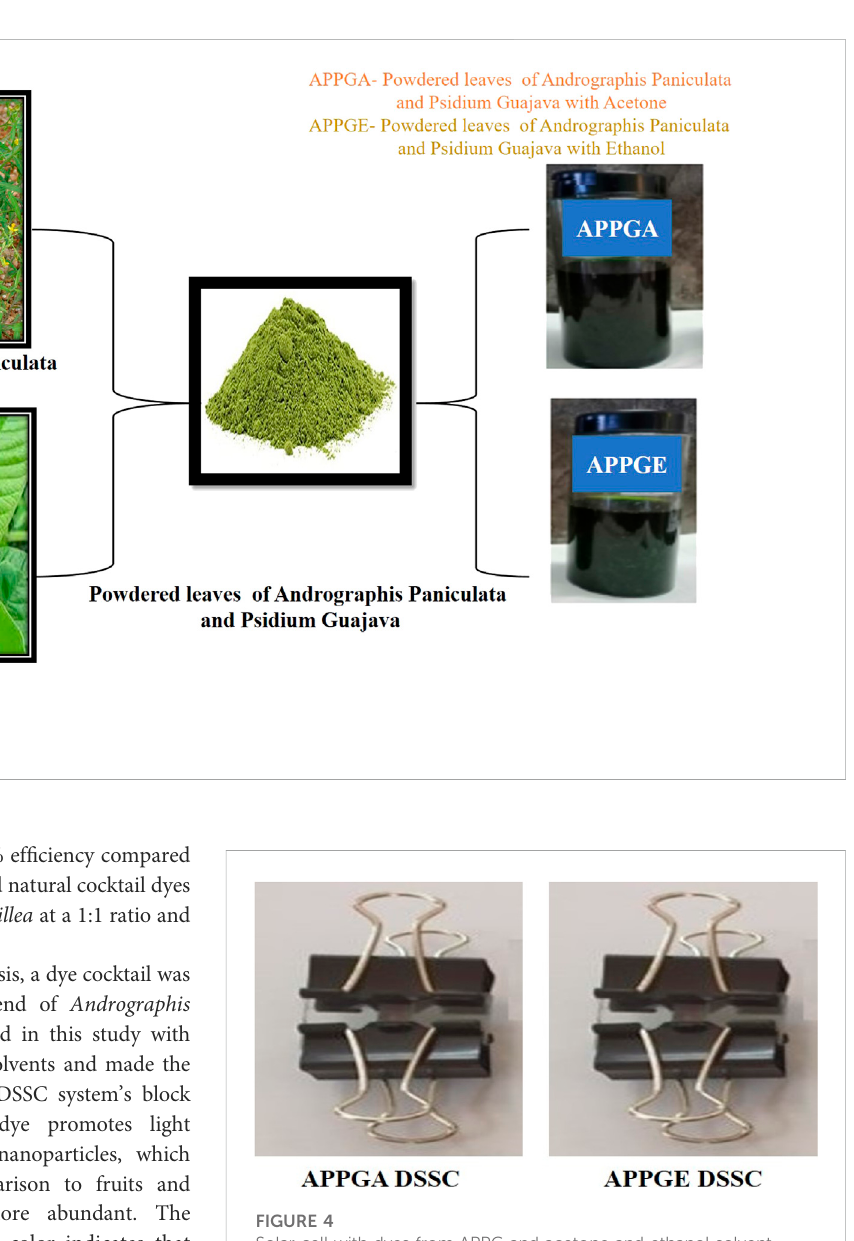
concentrated nitric acid. Using a porcelain mortar, the paste